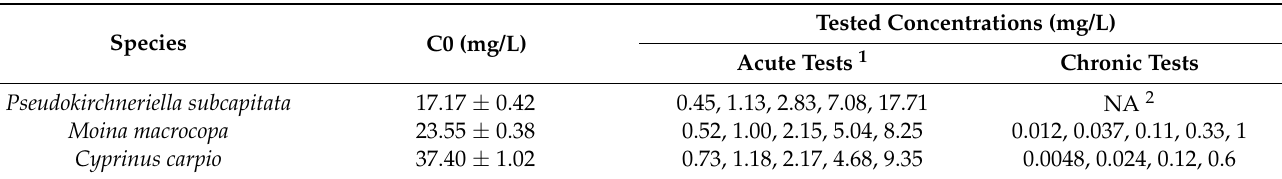
Table 1. The maximum concentration (C0) of BP-3 in each medium (ATCC, M4 and fish water) and the concentrations used in acute and chronic toxicity